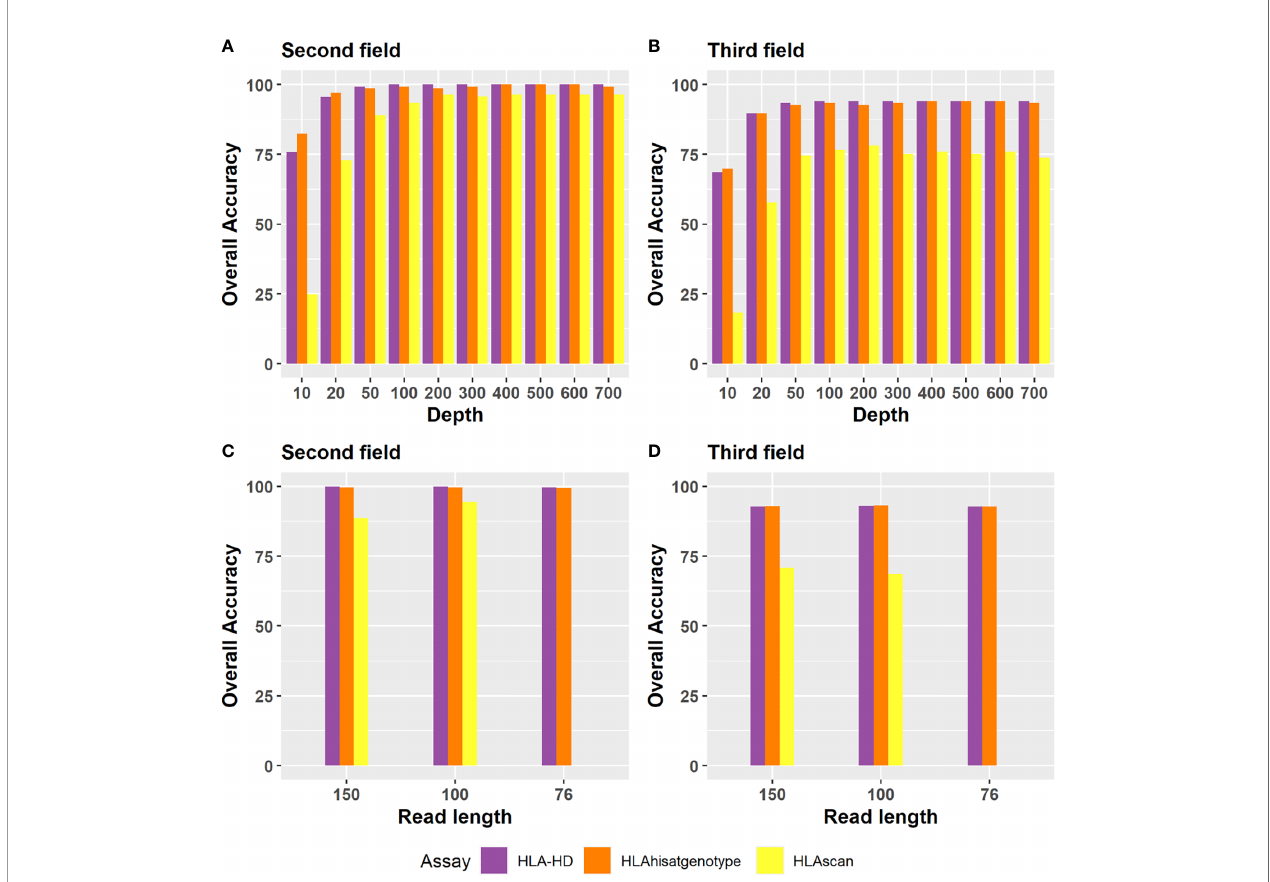
FIGURE 5 | Accuracy of the three tools for HLA typing at the second fi eld or the third fi eld resolution for different depths and read lengths. Depth evaluation at (A) the second fi eld level; (B) the third fi eld level. For sequence depth evaluation, alignment fi les of the 24 Bofuri samples were down-sampled from 700X to 10X based on the raw depths of HLA genes. (C, D) are the overall HLA typing accuracy at the second fi eld and the third fi eld level, respectively, while the read length decreased from 150 bp to 76